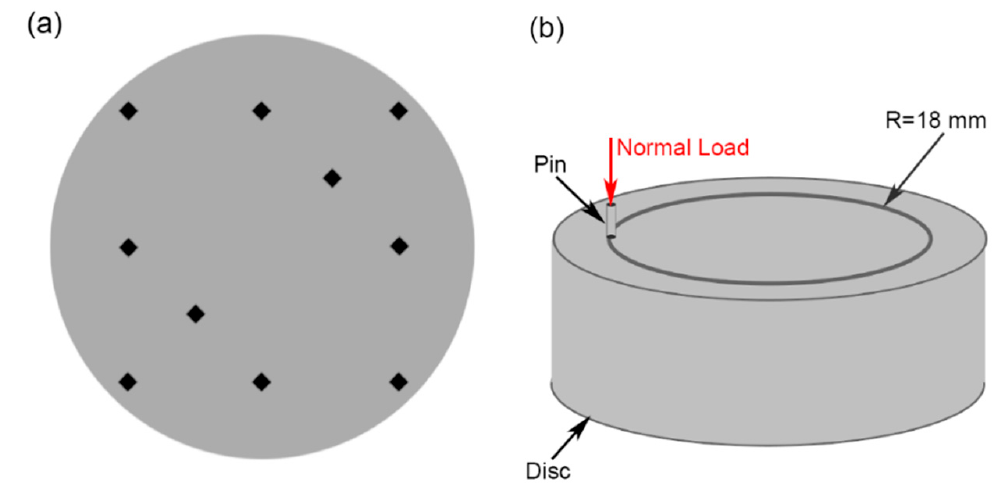
Figure 1. ( a ) the loading positions (black prism) of wear test; ( b ) the wear test in pin-on-disc apparatus.